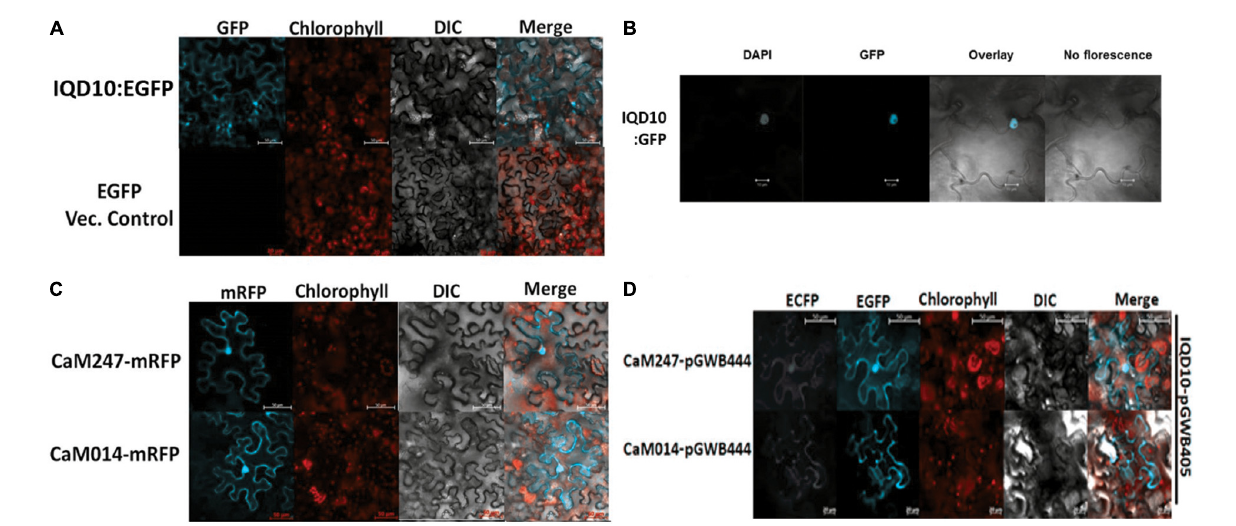
FIGURE 4 | Subcellular localization of PdIQD10, CaM247 and CaM014. (A) Subcellular localization of PdIQD10-GFP was detected in the cytoplasm and plasma membrane. The fluorescence was detected uniformly throughout the cell post 72 h of agroinfiltration of tobacco leaves with the Agrobacterium clone containing PdIQD10 in pGWB405 vector. (B) Repeated assays detected PdIQD10-GFP localization in the nucleus of tobacco leaves agroinfiltrated with the clone harboring the same construct PdIQD10 in pGWB405. (C) CaM247-mRFP and CaM014-mRFP were found to be localized throughout the tobacco cells and in nucleus upon agroinfiltration of clones harboring CaMs in pGWB454 vector. (D) Co-localization of PdIQD1-EGFP with CaM247-CFP or CaM014-CFP was performed by mixing the Agrobacterium cultures in equal (1:1) ratio before agroinfiltration into tobacco leaves. To increase accessibility of these subcellular localization images, the yellow color channel was converted to magenta uniformly across all images in the CMYK color spectrum. The original RGB color scheme images are provided in Supplemental Figure 10 . The color scheme is as follows: GFP/RFP: blue/cyan; chlorophyll, FM64 and mCherrry: red/orange; DAPI/CFP: